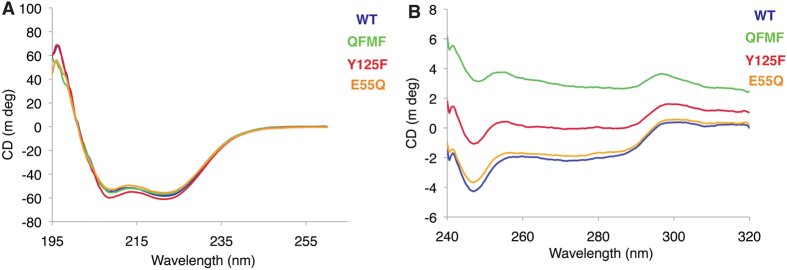
CD spectroscopy of wild-type eRF1 and its mutants, E55Q, Y125F and Q122FM(Y)F126 were measured at 25 °C on a Chirascan spectrophotometer (Applied Biophysics) in (A) far UV region and (b) near UV region depicting changes in the tertiary fold as a result of mutations. All samples were analyzed in NMR buffer (20 mM MES-K, pH 6.0, 100 mM KCl).